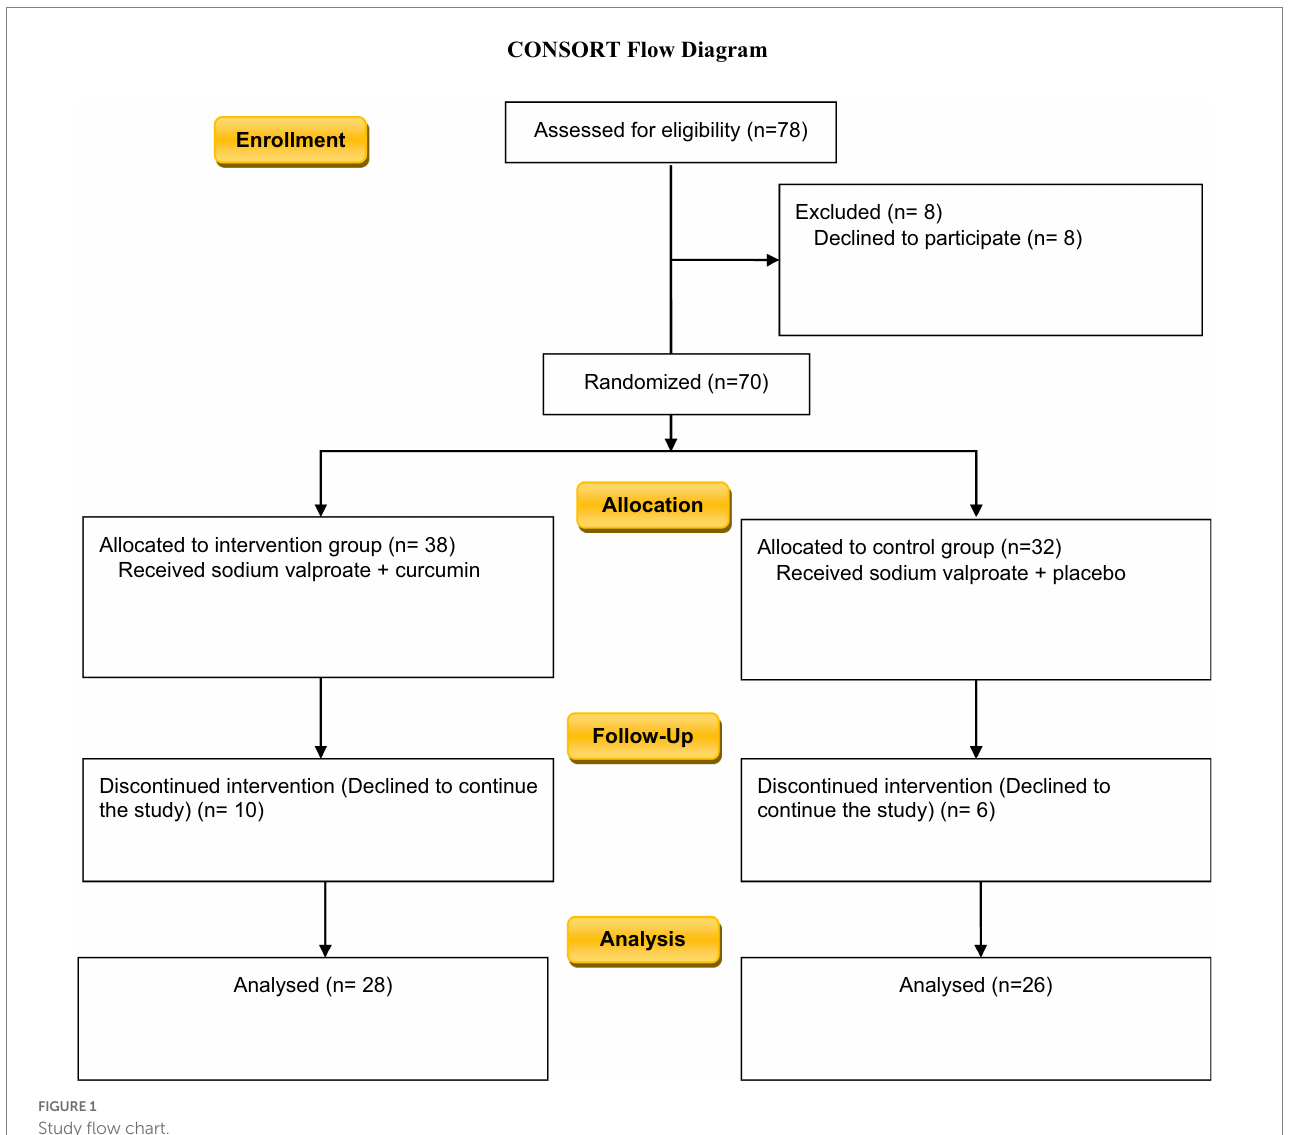
FIGURE 1 Study flow